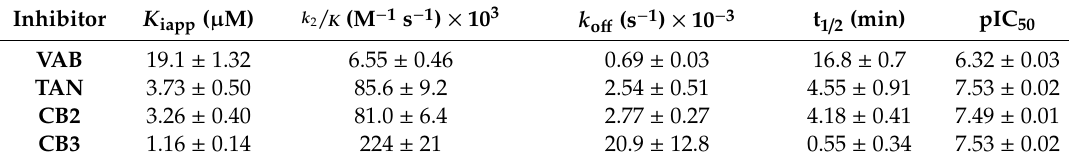
Table 1. Kinetic analyses of AmpC EC inhibition by (bi)cyclic boronates in vitro . K iapp values and pseudo first-order rates ( k 2 / K ) were determined by assaying 100 nM AmpC EC with 5 µ M FC-5 [36]. k o ff rates were determined after jump-dilution (100,000 fold) of AmpC EC (1 µ M) that had been pre-incubated with cyclic boronates (10 µ M for TAN, CB2 and CB3 and 100 µ M for VAB) at room temperature for 30 min, then assayed using 25 µ M FC-5. pIC 50 s were obtained from assays using 500 pM AmpC EC and 5 µ M FC-5 following a 10 min inhibitor pre-incubation at room temperature. Bu ff er: 50 mM Tris,